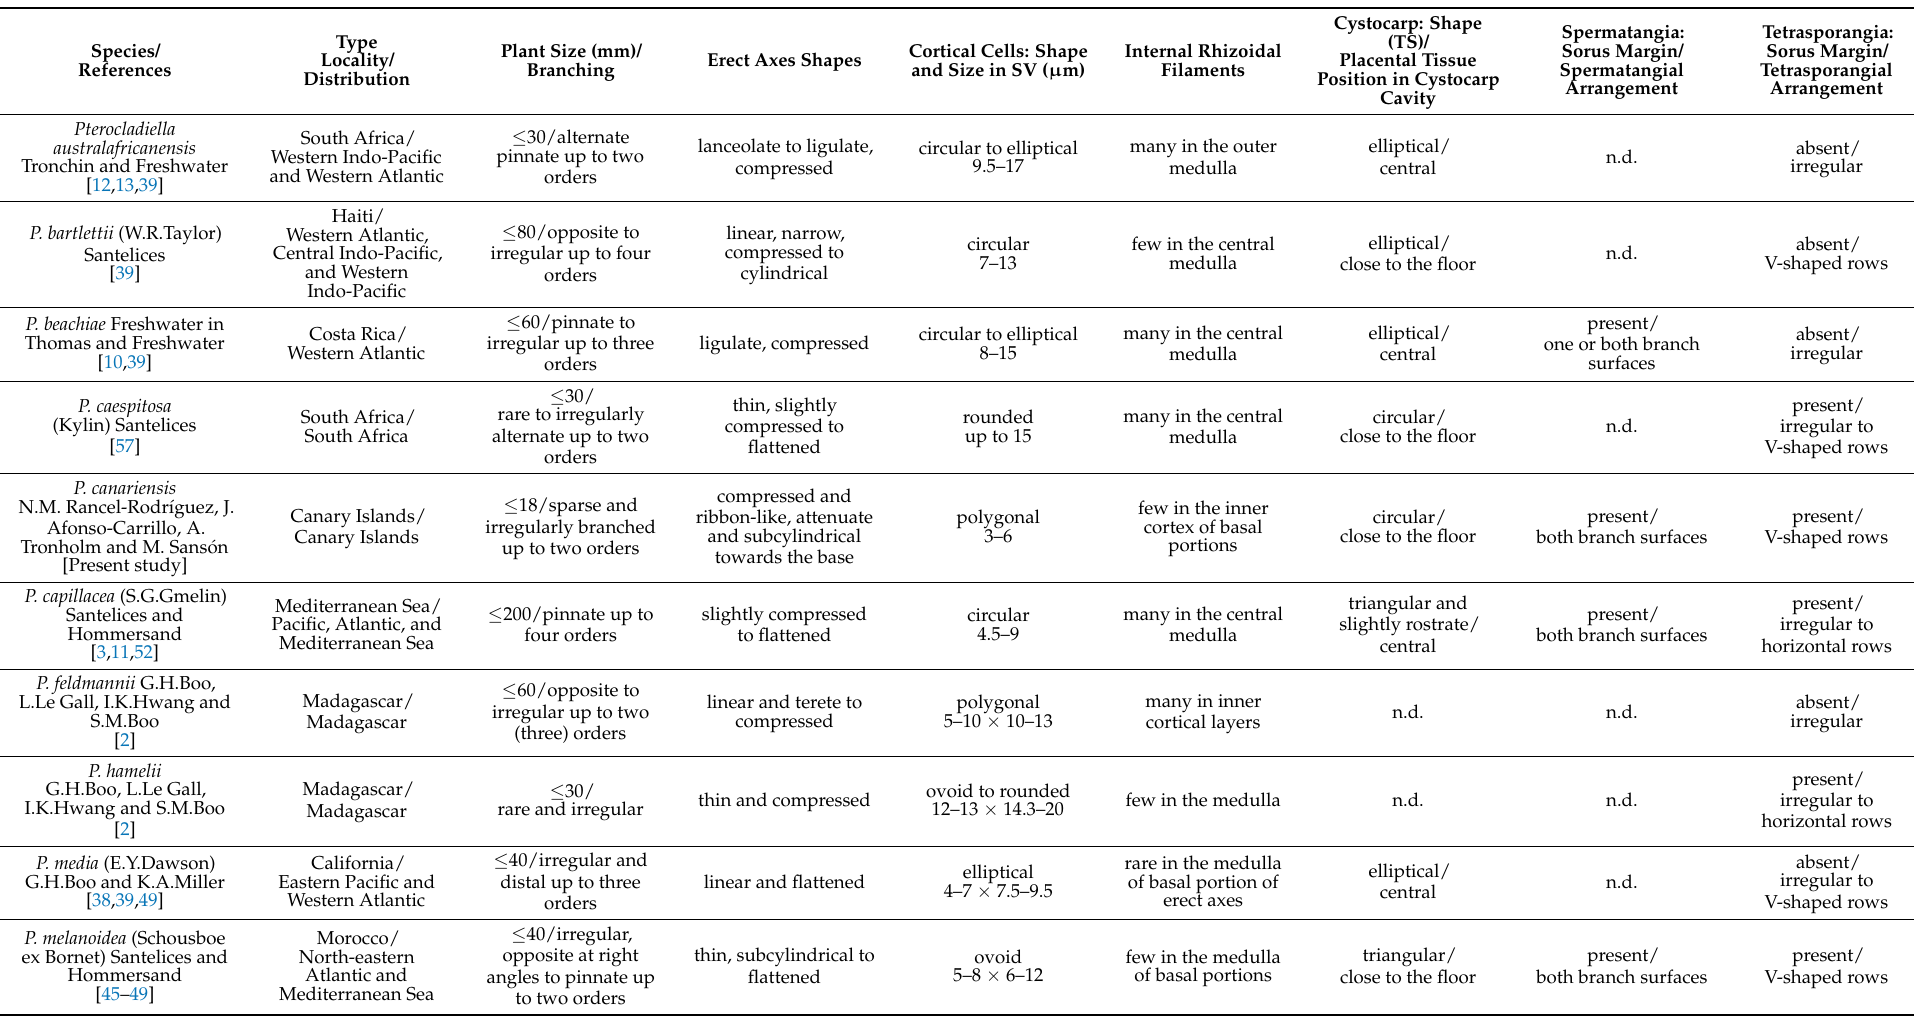
Table 1. Comparison of Pterocladiella canariensis sp. nov. and Atlantic and related